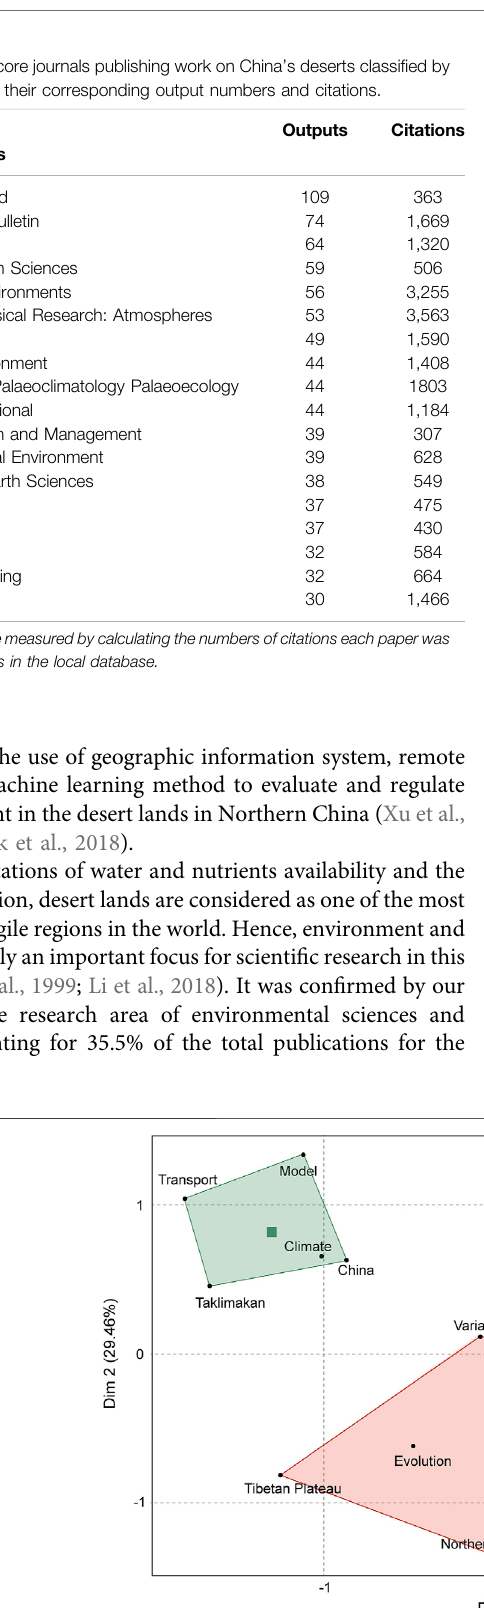
Frontiers in Earth Science |